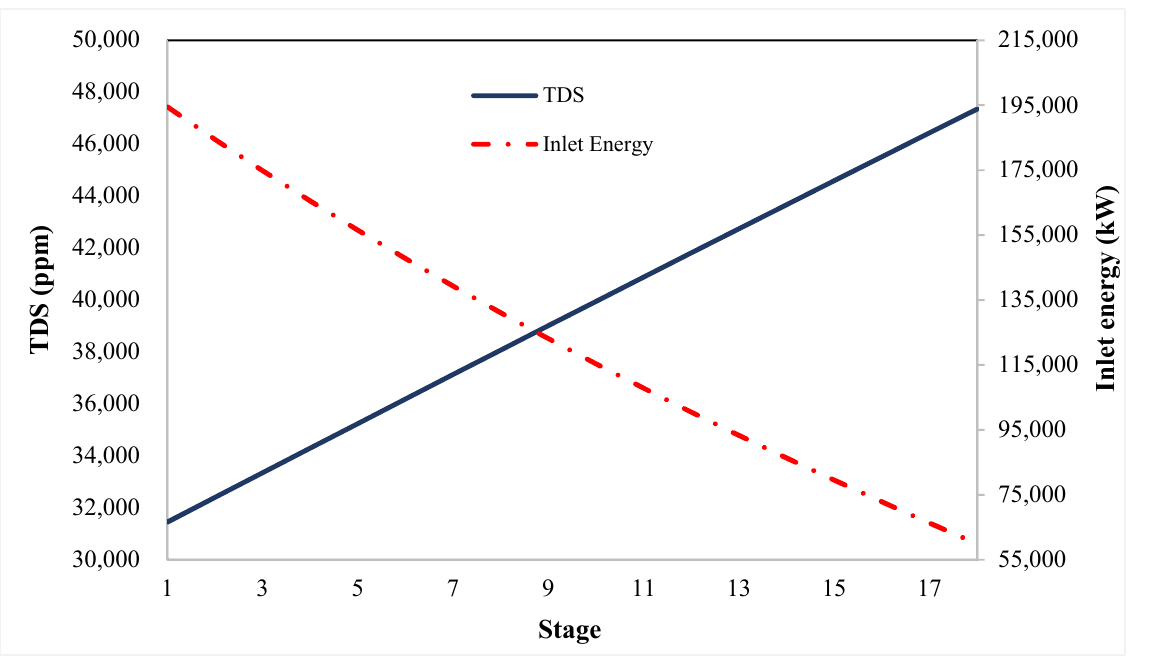
Figure 5. Variations of TDS and inlet energy in each stage.